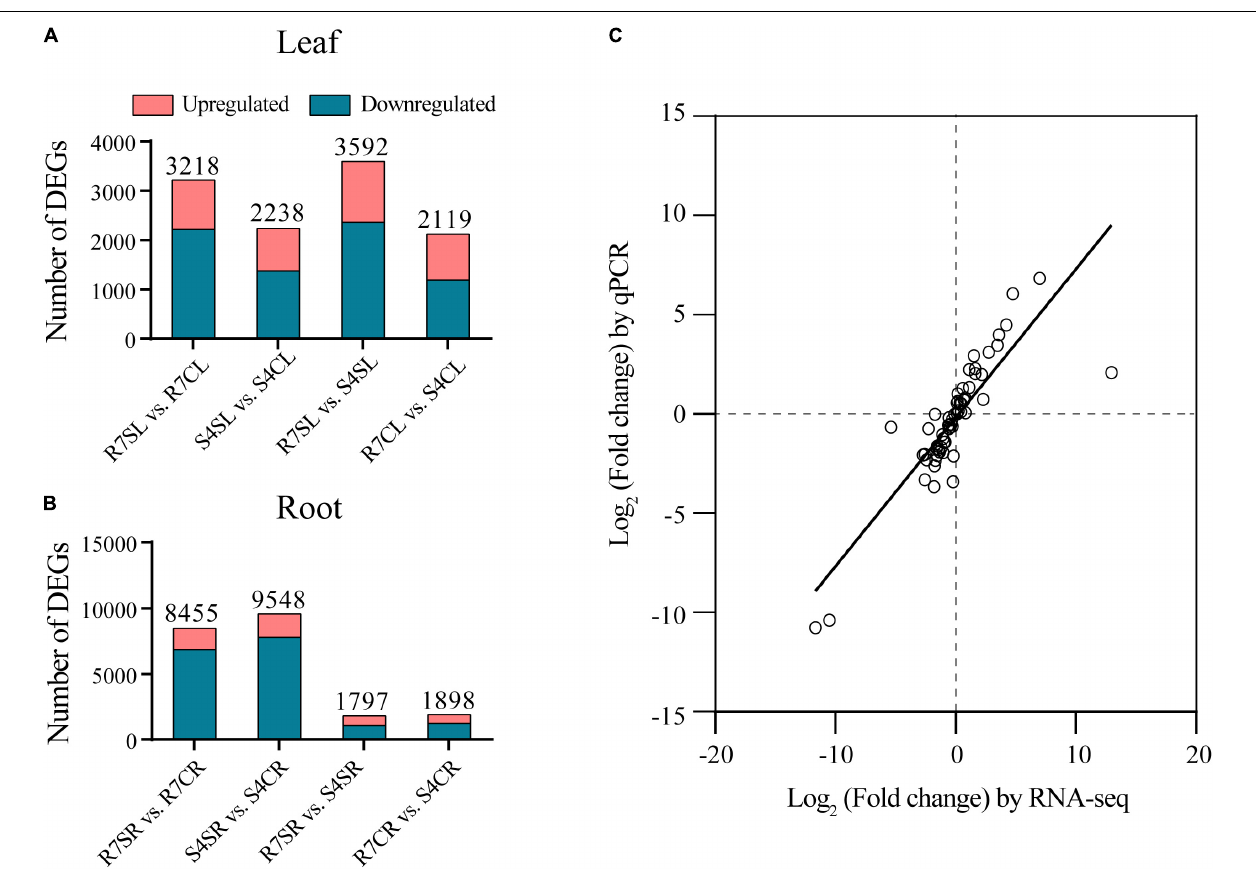
FIGURE 2 | Transcriptome data and the differentially expressed genes (DEGs) in F. velutina R7 and S4 plants with or without salt treatment. (A) The DEG number of each pairwise comparison in leaf samples. (B) The DEG number of each pairwise comparison in root samples. (C) Correlation between qPCR ( X -axis) and RNA-seq ( Y -axis) was calculated based on log2 (fold